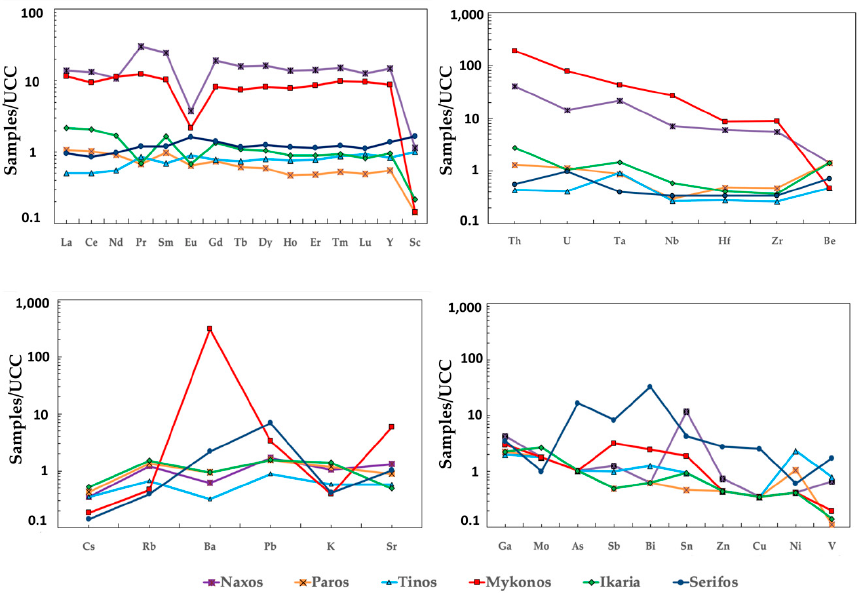
Figure 7. UCC-normalized spidergrams of coastal sands derived from different localities of the Atticocycladic zone (Mykonos, Serifos, Naxos, Tinos, Paros, Ikaria). Chondrite-normalized diagrams of REE (Figure 8) for sand samples derived from the Atticocycladic zone show clear overall similarities in terms of the negative slope and presence of